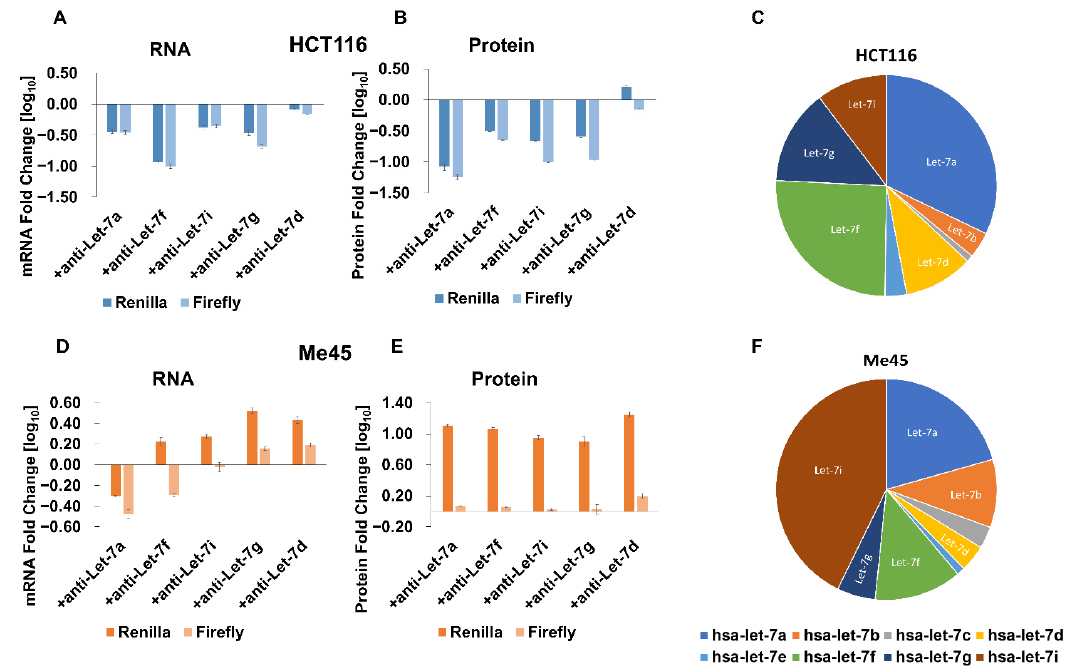
Figure 7. Influence of the inhibition of different Let ‐ 7 family members by anti ‐ Let7 miRNA oligo ‐ nucleotides on Renilla and firefly luciferase transcript ( A , D ), and protein ( B , E ) levels in HCT116 ( A , B ) and Me45 ( D , E ) cells. Bar graphs represent the decimal logarithm of the ratio of mRNA ( A , D ) or protein ( B , E ) levels in the presence of these in absence of an anti ‐ miR oligonucleotides. The rela ‐ tive abundances of the different Let ‐ 7 family members in HCT116 and Me45 cells are presented as pie charts ( C , F ), respectively.